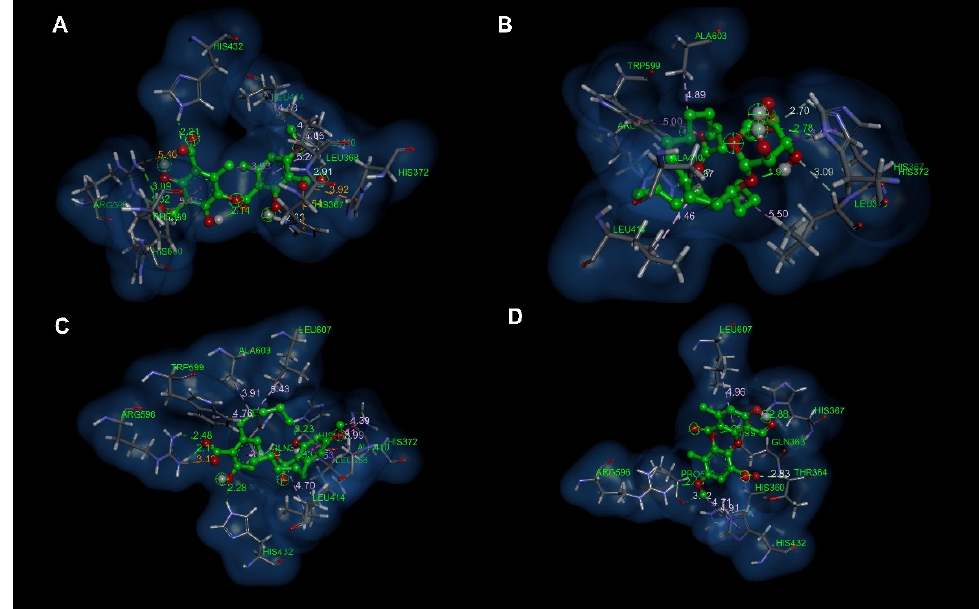
Figure 4. Molecular docking of compounds present in the species of Cladonia . ( A ) Higher affinity conformation of thamnolic acid with 5-LOX; ( B ) Higher affinity conformation of 13D acid with 5-LOX; ( C ) Higher affinity conformation of Perlatolic acid with 5-LOX; ( D ) Conformation of a higher affinity of psoromic acid with 5-LOX.